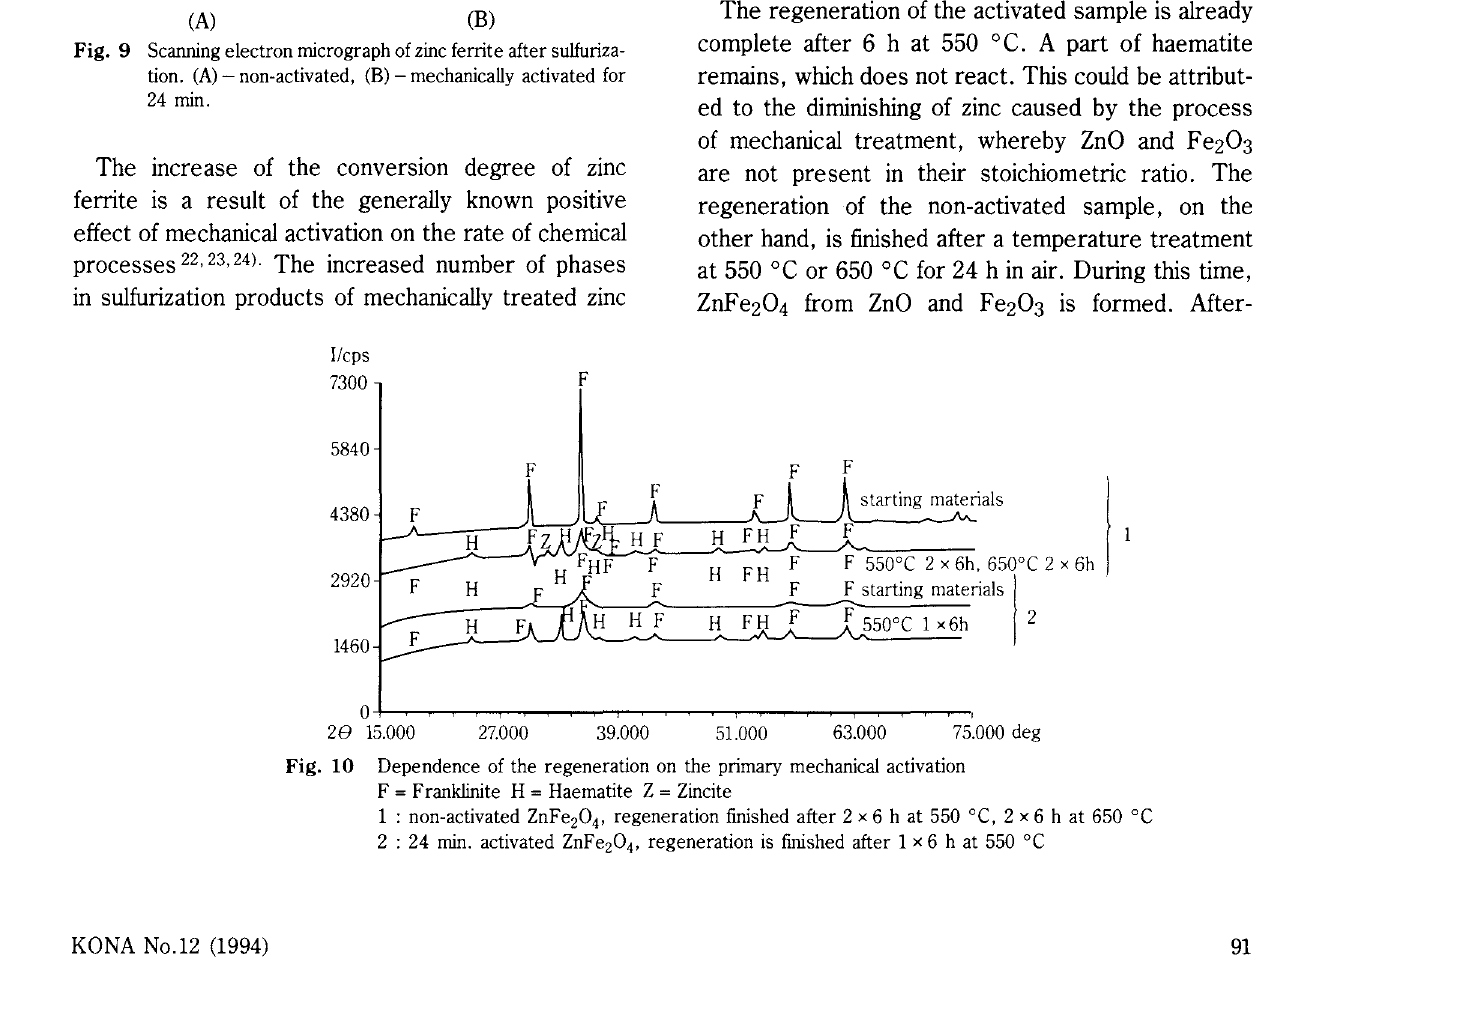
Fig. 8 Diffraction pattern of mechanically activated (24 min.) zinc ferrite after sulfurization